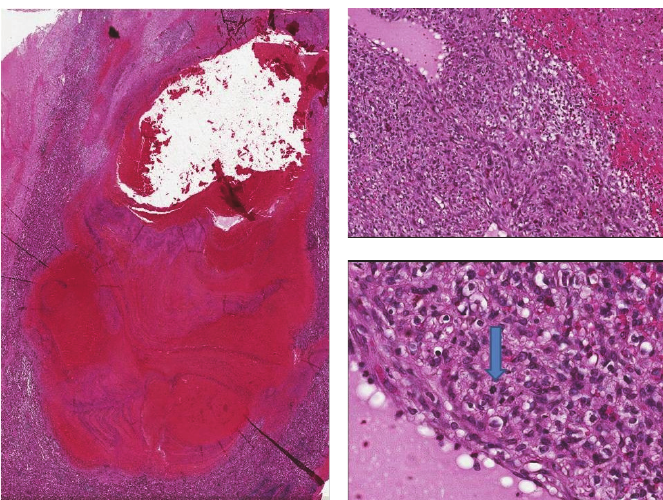
Figure 2: Histological findings: spleen angiosarcoma. At low-power field, histological sections revealed a large hemorrhagic areas with fibrin necrosis (H&E, 4x); at the periphery, foci of a solid vascular proliferation were evident (H&E, 10x). Spindle sarcomatoid cells with prominent hyperchromatic large elements characterized this high grade tumor. At high power field, atypical mitosis (arrow) and pseudovascular spaces were compatible with a final diagnosis of angiosarcoma (H&E,